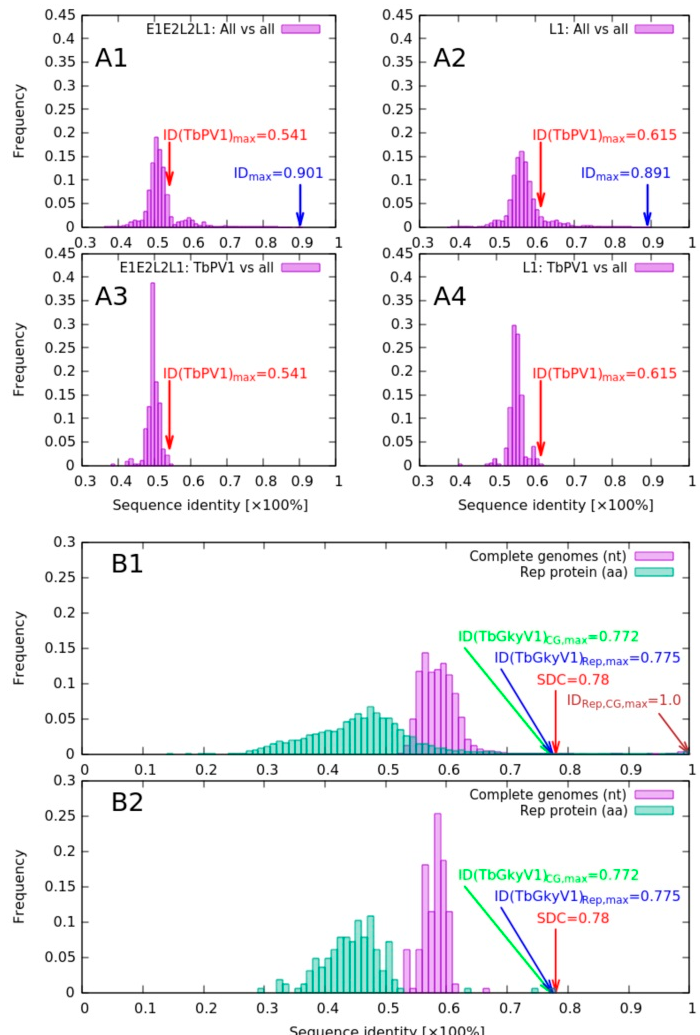
Figure 3. Frequency distribution of pairwise identity values from nucleotide sequence comparisons of PV and genomovirus genome regions. ( A ) Nucleic sequence identity histograms of the 377 PV nucleotide sequences (A1 and A2) and TbraPV1 (A3 and A4) based on the concatenated E1, E2, L2, and L1 gene sequences (A1 and A3) and on the L1 gene sequence (A2 and A4). Multiple sequence alignments were constructed using Muscle (v3.8.31) [47], and the distance matrices were estimated using SeaView v4.7 [49], as suggested in Bernard et al. (2010). Red arrows indicate the maximum sequence similarities of TbraPV1 for each of the sequence contexts ( E1, E2, L2, and L1 concatenation and the L1 gene sequence). The blue arrows (A1 and A2) indicate the overall maximum sequence identity in the depicted context ( E1, E2, L2 , and L1 concatenation and the L1 gene sequence). The histograms were visualized using gnuplot (v5). ( B ) Pairwise sequence identity histograms based on 167 complete genome nucleotide (purple) and Rep gene (green) amino acid sequences from the Genomoviridae family, based on the entire pairwise identity distance matrices (B1) and on the matrix slices representing pairwise identities of TbGkyV1 to all other 166 Genomoviridae sequences (B2). The pairwise similarity matrices were obtained through pairwise sequence alignments (Muscle v3.8.31) [47], using Sequence Demarcation Toolkit (SDT v1) [55]. For the arrows in the histogram: red = the species demarcation threshold / criteria (SDC) for Genomoviridae [70]; green and blue = maximum pairwise identity values of TbGkyV1 for the complete genome (green) and the Rep protein sequence contexts (blue). Histograms were visualized using gnuplot (v5). nt = nucleotide, aa = amino acid, SCD = sequence demarcation threshold / criteria [70]. CG: complete genome.